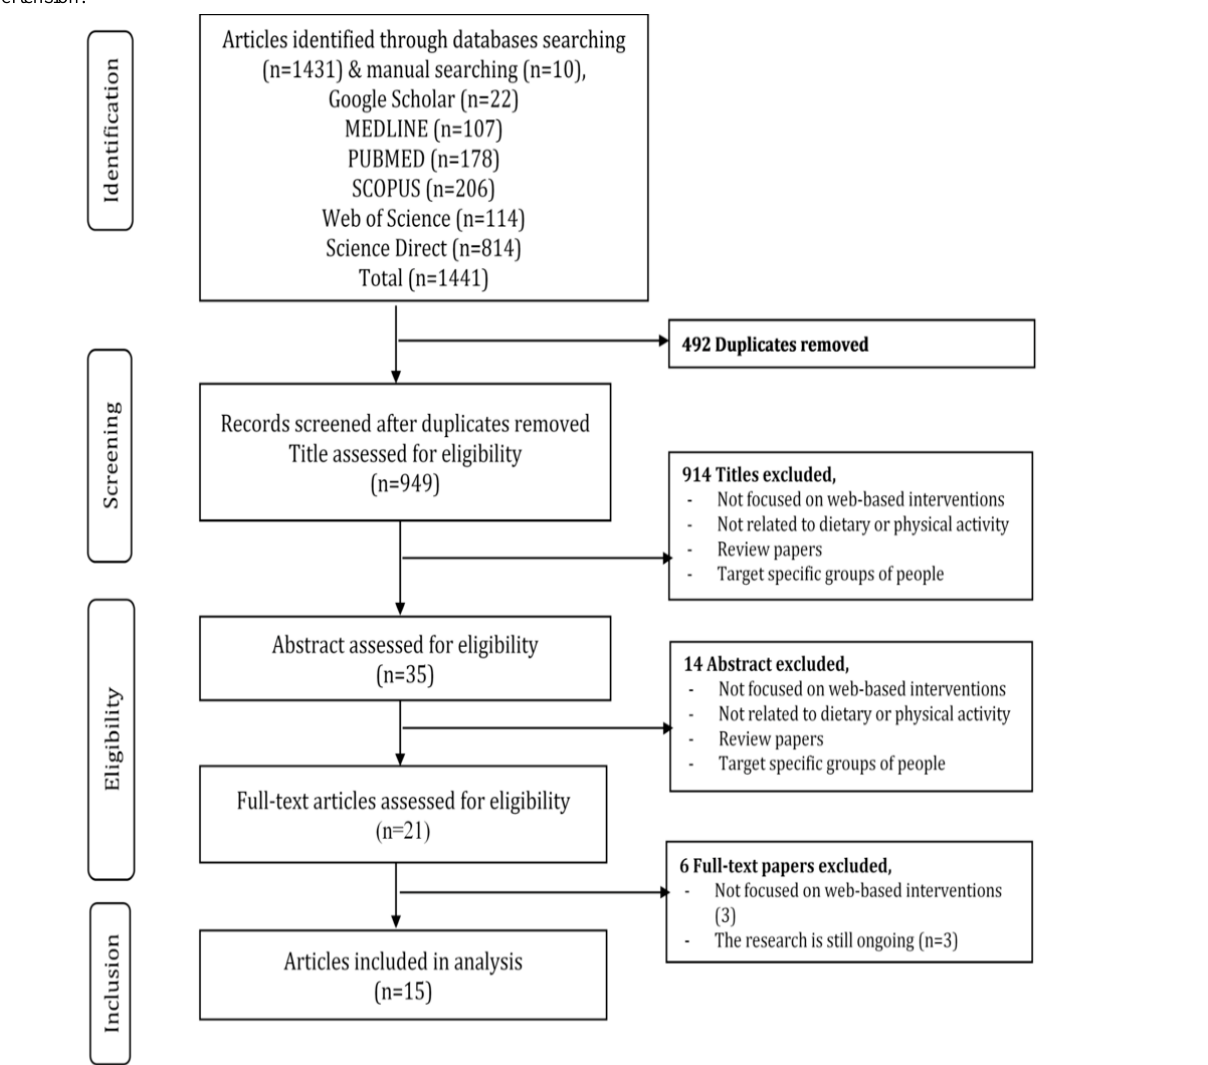
Figure 1. Flow diagram depicting the inclusion of studies that used web-based dietary and physical activity intervention programs for patients with